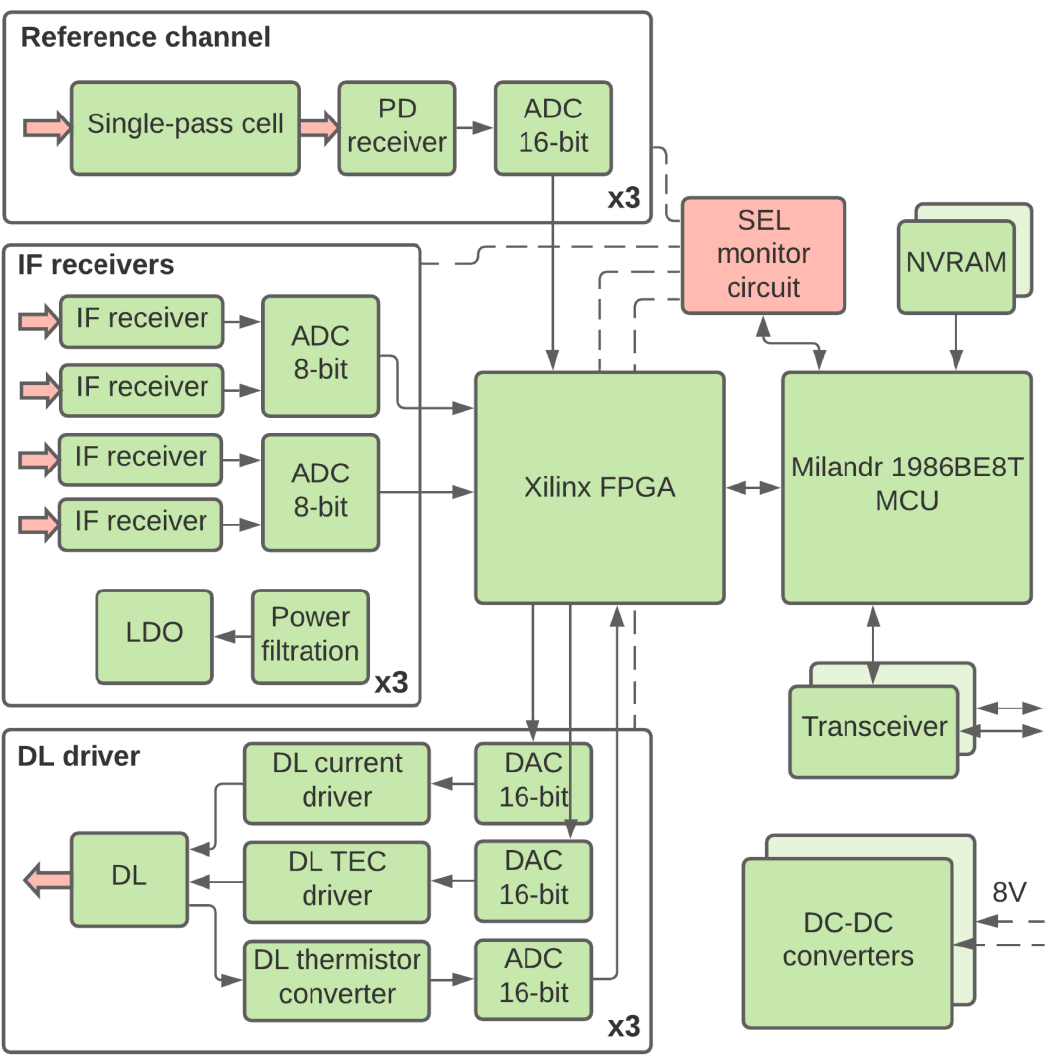
Figure 13. The diagram of MLHS electronics. ADC is an analog to digital converter; DAC is a digital to analog converter; DL is a diode laser; PD is a photodiode; SEL is single-event latch-up; NVRAM is non-volatile random-access memory; FPGA is a field-programmable gate array; MCU is a microcontroller unit; LDO is a low dropout regulator; TEC is a thermoelectric